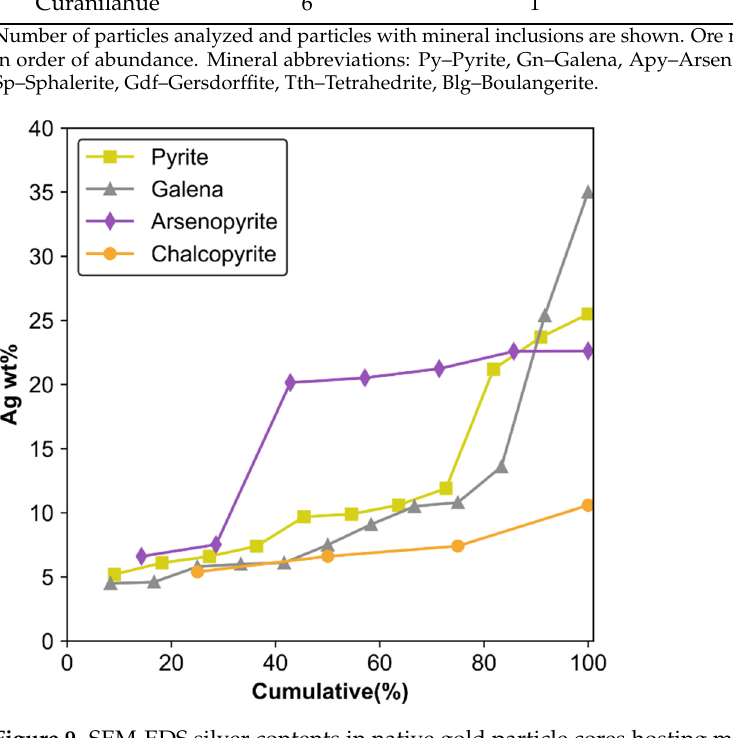
Table 1. Ore minerals found as inclusions in native gold particles. Total Particles Particles with Ore Placer Location Analyzed Mineral Inclusions La Familia Potrerito